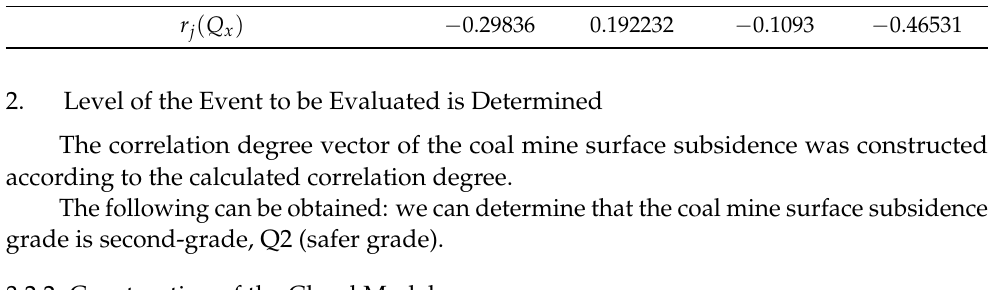
Table 7. Comprehensive correlation degree of mine surface subsidence to evaluation grade. Comprehensive Correlation